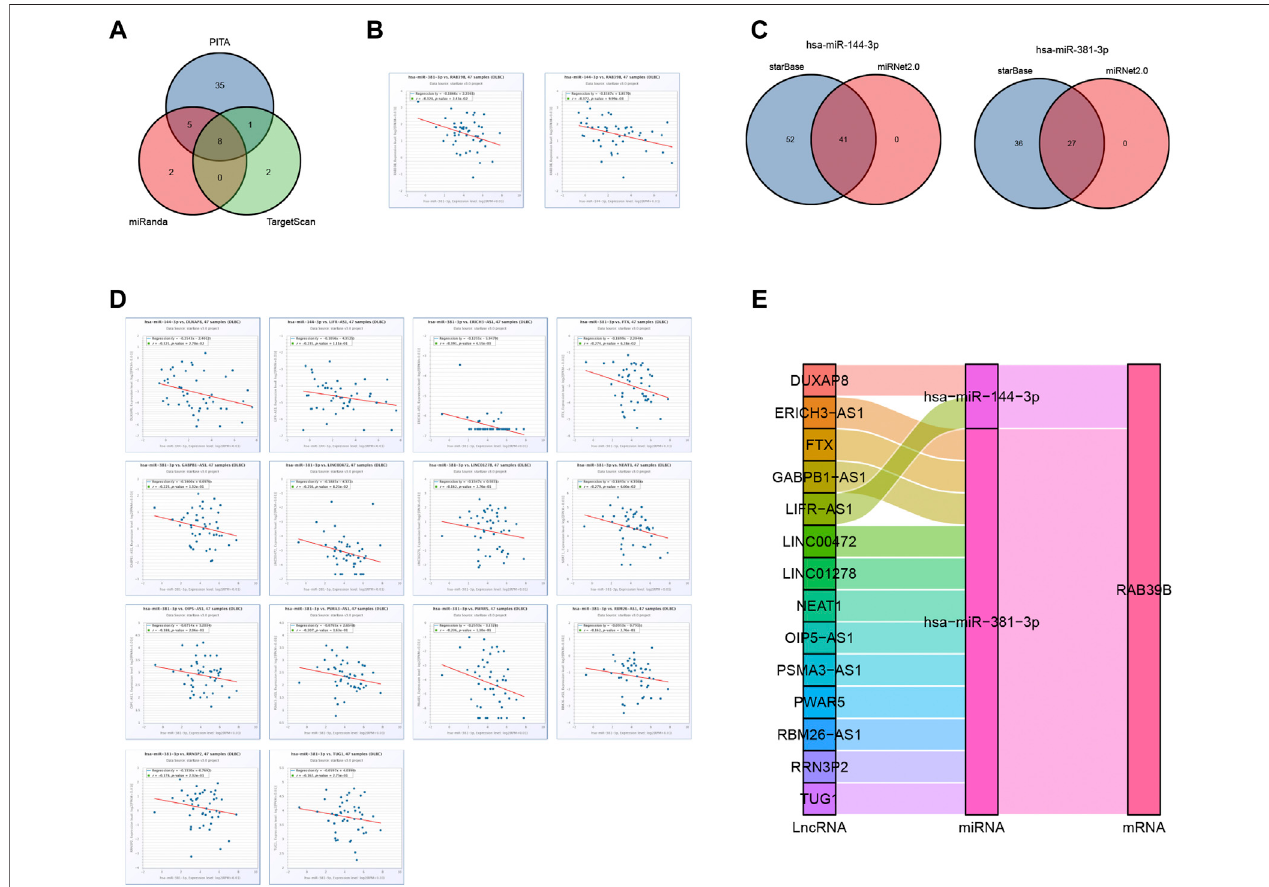
FIGURE 6 | RAB39B-related key ceRNA network construction in DLBCL. (A) Venn diagram of predicted RAB39B targets in PITA, miRanda, and TargetScan. (B) Correlation between RAB39B and the target miRNAs in scatter plots. (C) Venn diagram of predicted target lncRNAs of hsa-miR-144-3p and hsa-miR-381-3p in starBase and miRNet. (D) Correlation between hsa-miR-144-3p or hsa-miR-381-3p and the target lncRNAs in scatter plots. (E) lncRNA – miRNA – mRNA (RAB39B) regulatory network in line with the ceRNA hypothesis was constructed in the Sankey diagram.